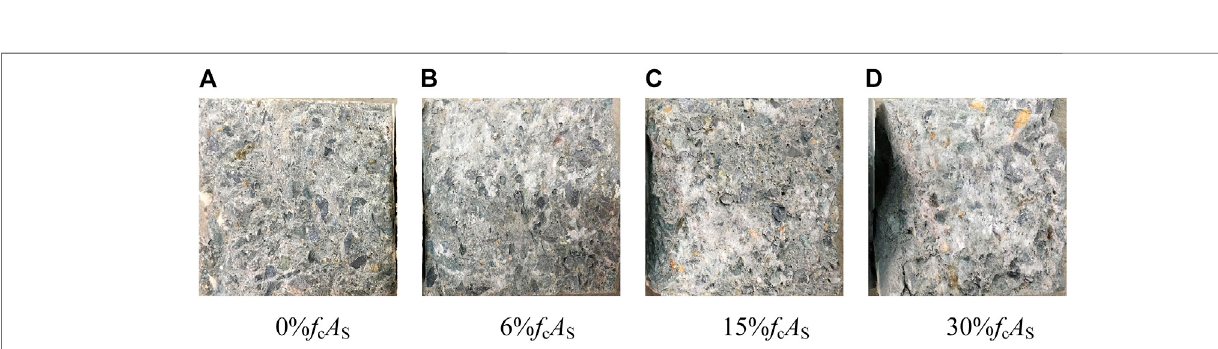
Frontiers in Materials |